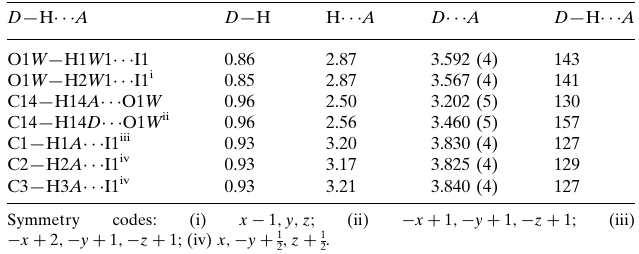
Hydrogen-bond geometry (A˚ , (cid:3)